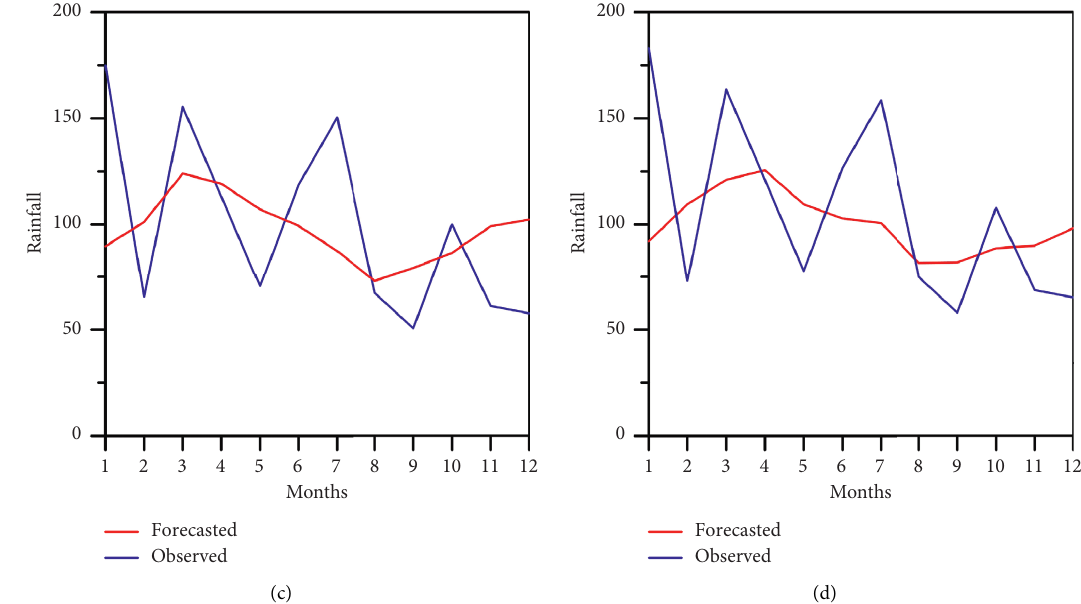
Figure 5: Comparison between predicted and observed values: (a) observed vs forecasted subset for Labrado; (b) observed vs forecasted Chirimachay; (c) forecasting for Labrado in 2015; (d) forecasting for Chirimachay in